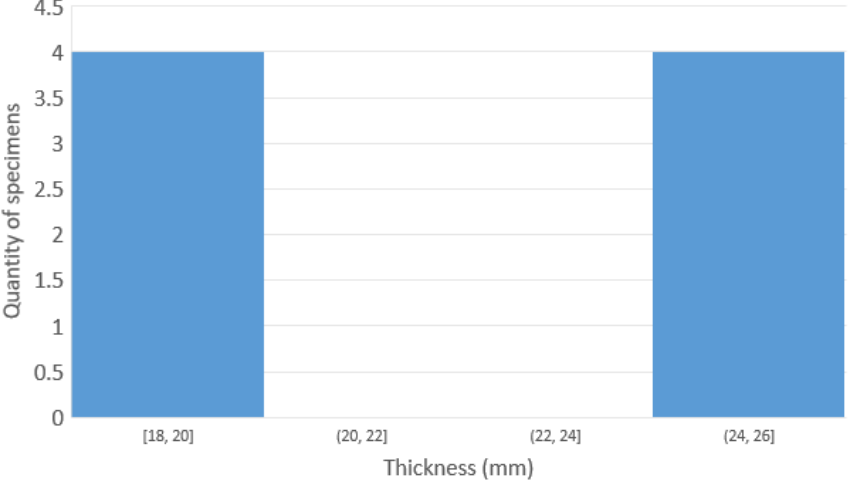
Figure 15. Histogram of thickness with FC transverse butt-welded joint Figure 17. Histogram of thickness with FC transverse butt-welded joint samples . Figure 19. Histogram of thickness with in-air tubular joint samples .